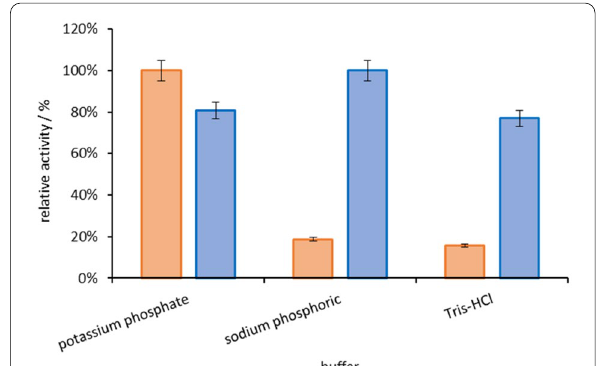
Fig. 1 The activity of GldA (orange bar) and SpNox K184R (blue bar) with different kinds of buffer